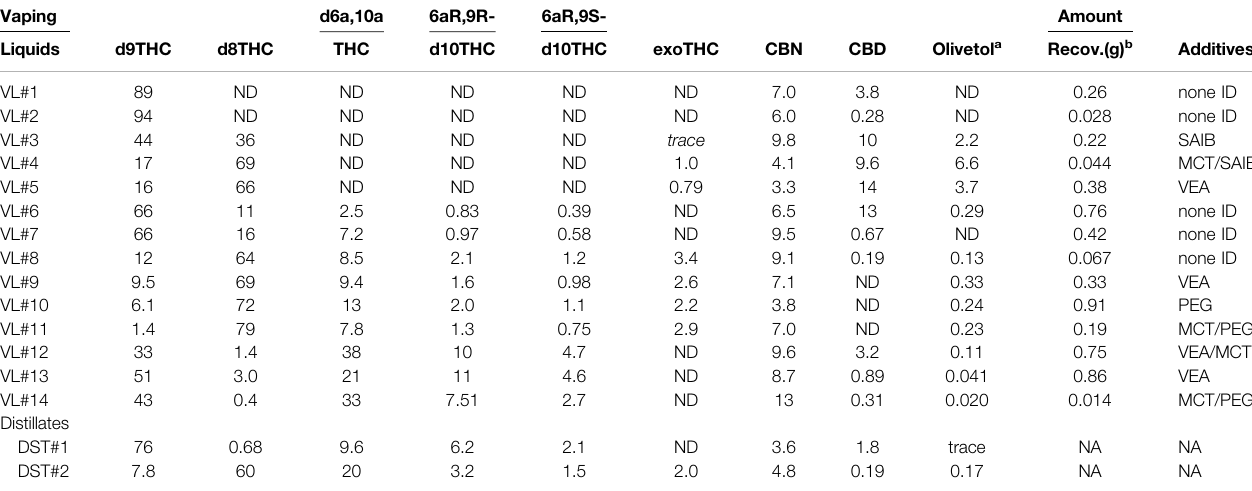
TABLE 1 | GC-MS peak area percentages (PAPs) for cannabinoids and olivetol in vaping liquids and bulk THC distillates. Vaping d6a,10a 6aR,9R- Liquids